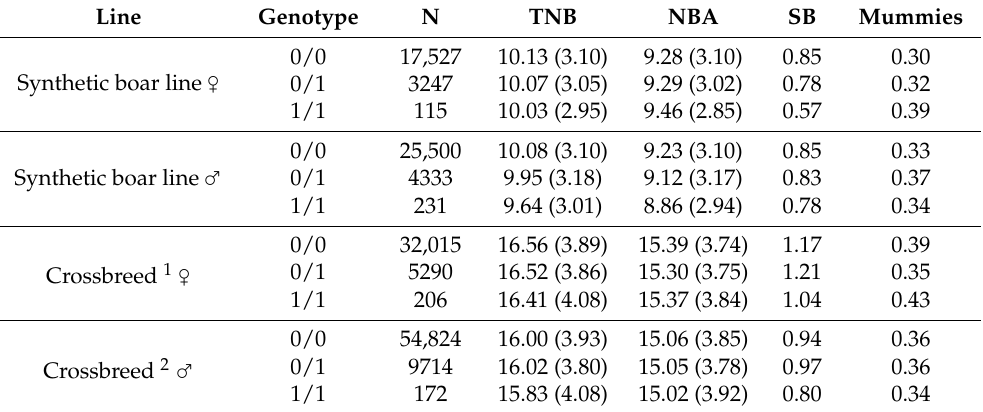
Table 6. Descriptive statistics of total number born (with SD), number born alive (with SD), number of stillborn, and mummies per genotype of rs81300422 for sows line and its